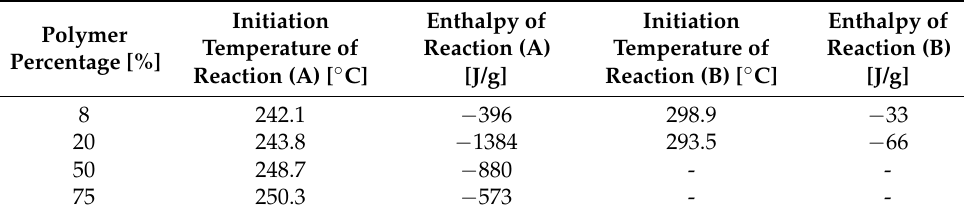
Table 1. Results of DSC analysis of AN and uPVC mixture with different